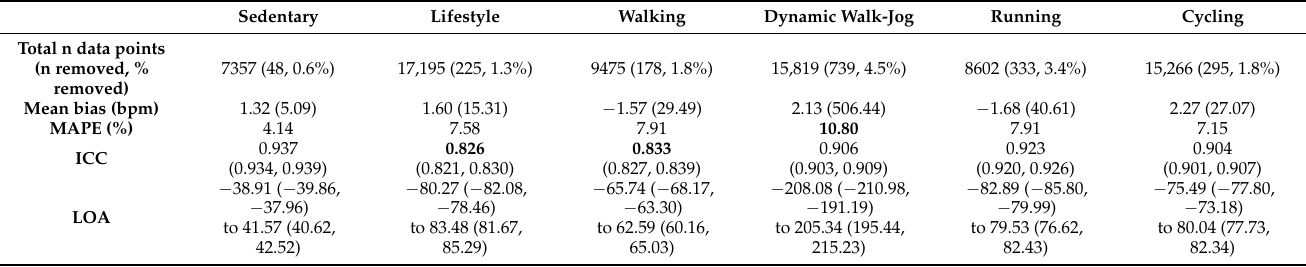
Table 3. Results of all tests for the Jabra Elite earbuds. Bold values indicate MAPE > 10% and ICC < 0.90. Sedentary Lifestyle Walking Dynamic Walk-Jog Running Cycling